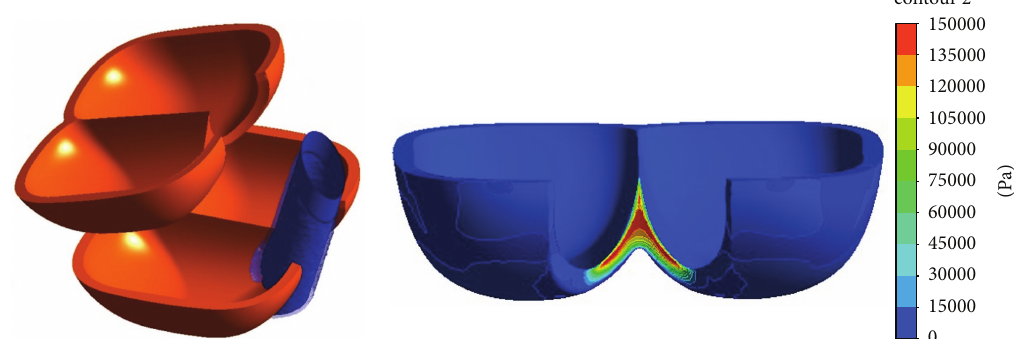
Figure 9: High pressure development at the backside while the jet is entering the bucket.